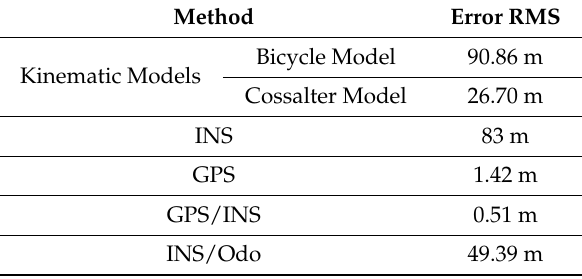
Table 2. Resulting precision of trajectory reconstruction